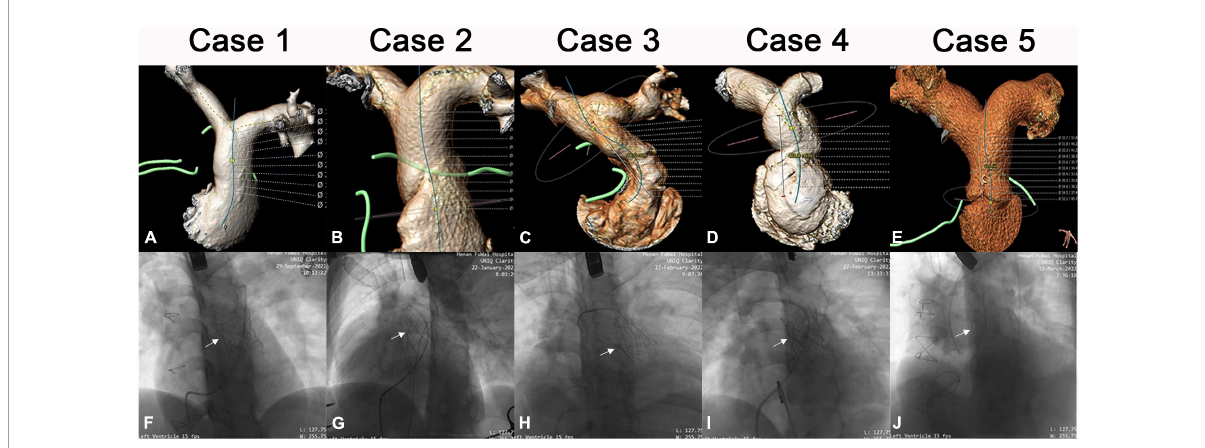
FIGURE1 Imaging data of patients 1–5. Pre-operative CTA image of each patient (A–E) . Intraoperative image after Salus-valve (white arrows) deployment of each patient (F–J) .